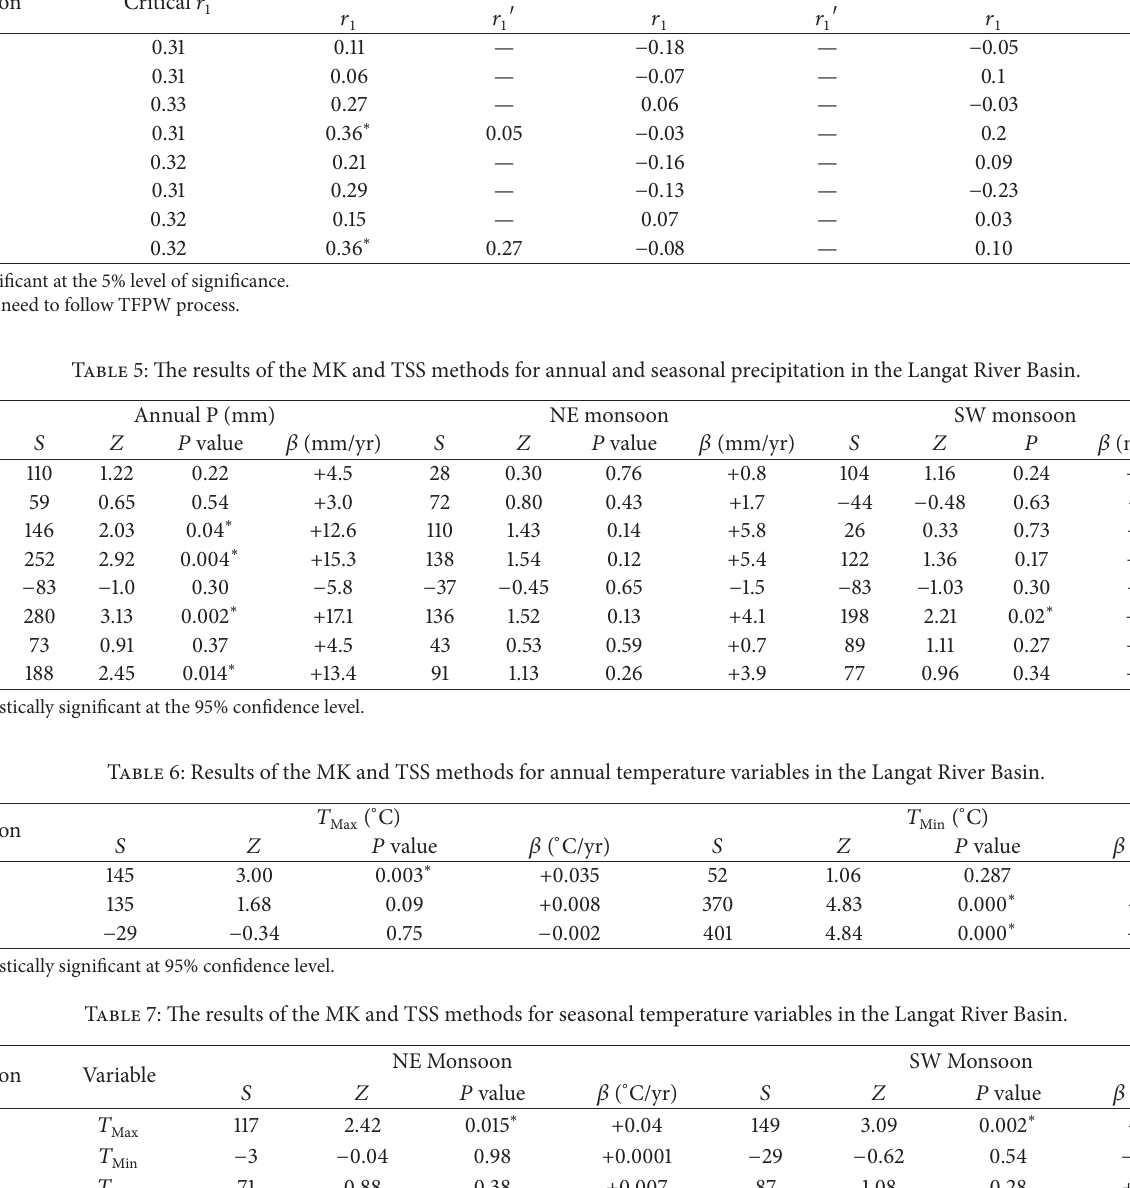
Table 4: Lag-1 serial correlation values for annual and seasonal precipitation before and after TFPW process ( 𝑟 1󸀠 ). Station